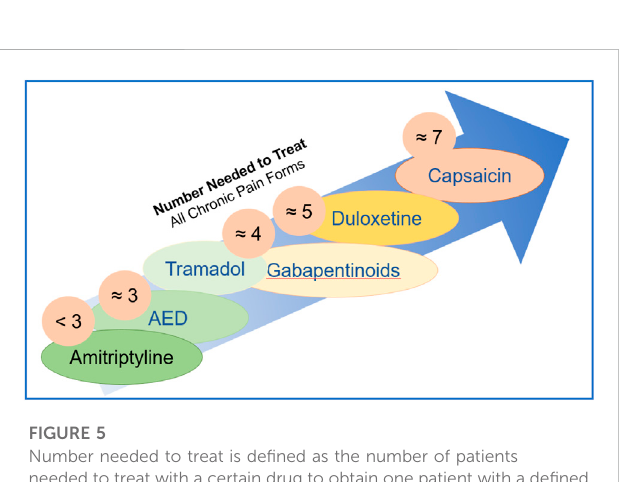
FIGURE 5 Number needed to treat is de fi ned as the number of patients needed to treat with a certain drug to obtain one patient with a de fi ned degree of pain